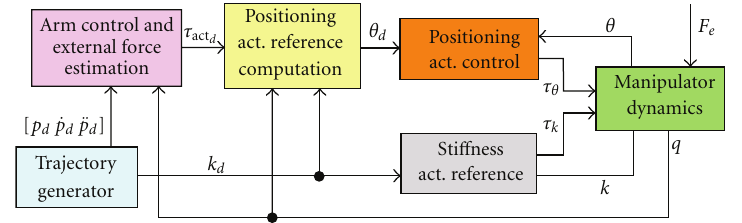
Figure 2: Scheme of the overall output-based